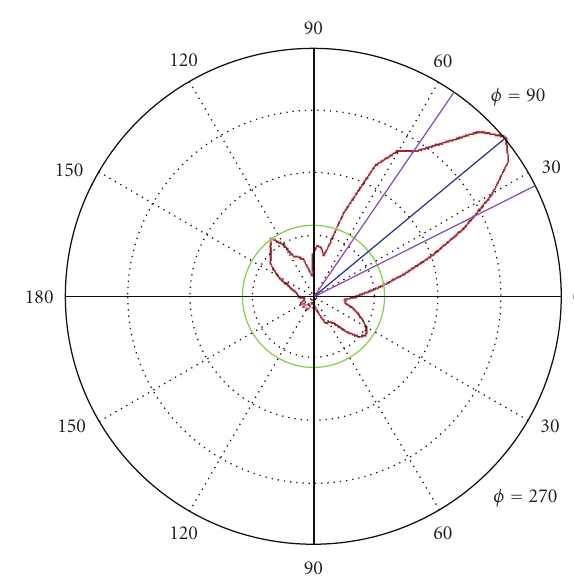
Figure 10: Radiation patterns of electric field (H plane) LWA Type III, at 9.5 GHz.